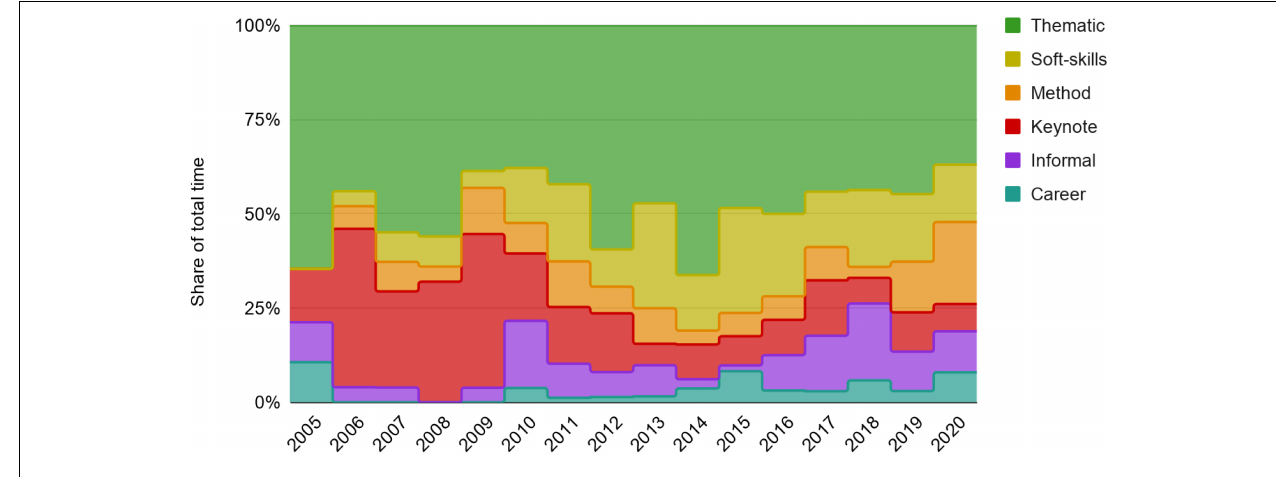
FIGURE 2 | Share of total time of different session types against